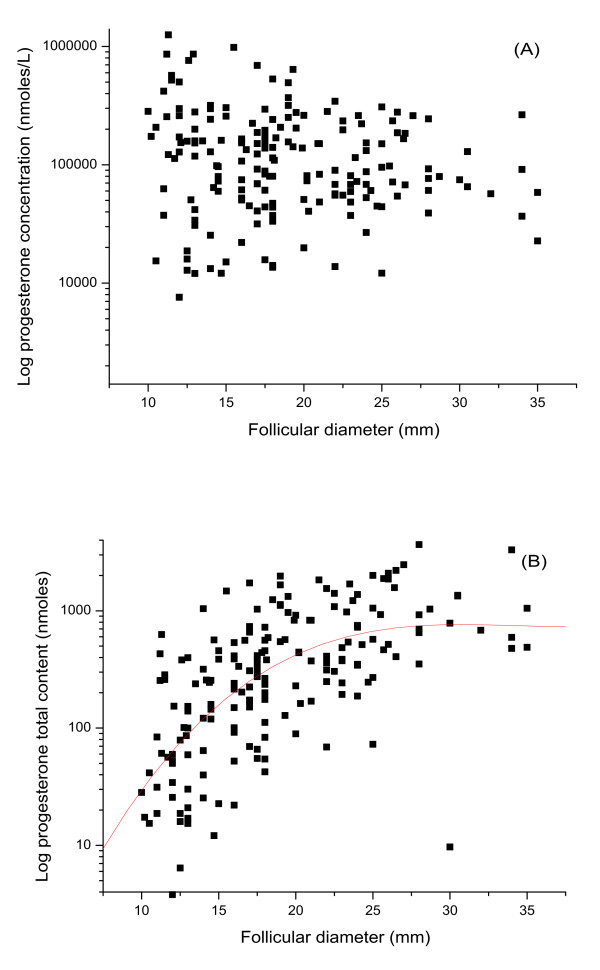
Follicular progesterone. Scatter plots to show the correlation of progesterone concentration (nmoles/L) (a) and total content (nmoles) (b) with the follicular diameter (mm). The concentration slightly decreased (4a: r = -0.15, p < 0.05) but its total content increased with follicular size (4b: r = 0.64, p < 0.0001).